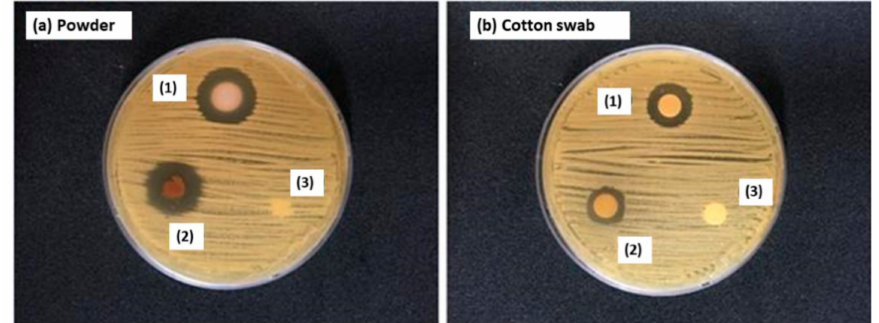
Figure 4. Antibacterial activity. Agar diffusion test using C. albicans . ( a ) Powder: ( a1 ) CHX powder; ( a2 ) propolis-embedded zeolite nanocomposites; ( a3 ) empty zeolite nanocomposites. ( b ) Cotton swab: ( b1 ) CHX solution; ( b2 ) elutes from propolis-zeolite/PLA-PCL pellets; ( b3 ) elutes from